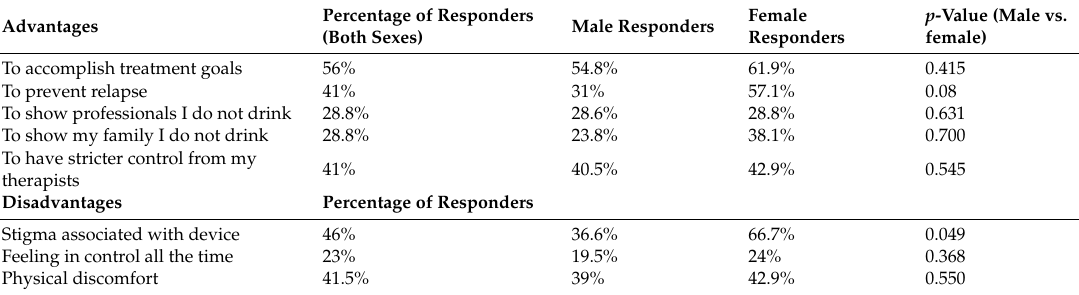
Table 1. Advantages and disadvantages attributed to transdermal sensors.